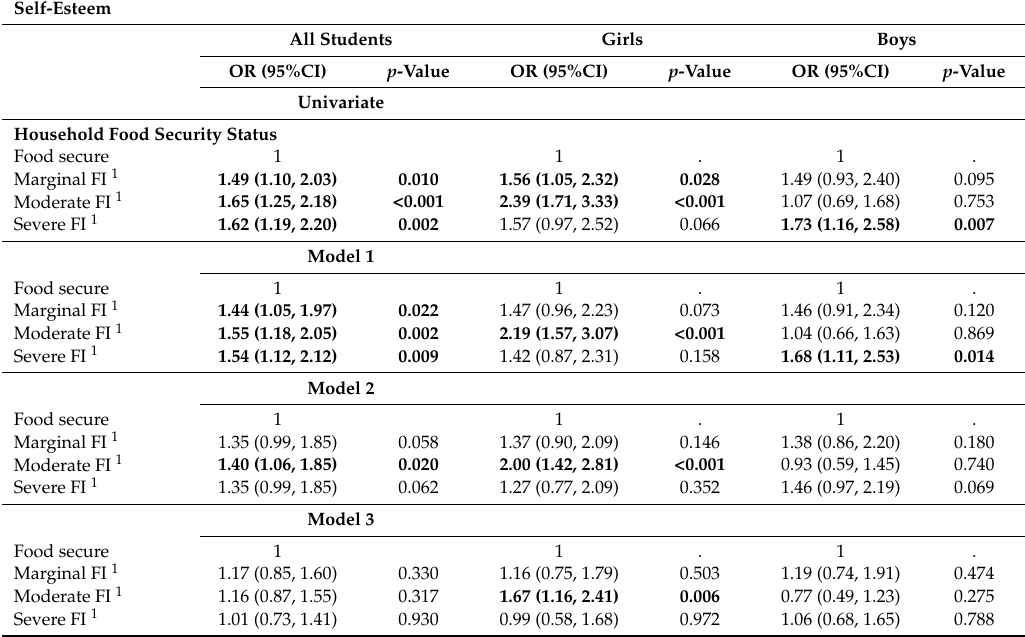
Table 2. Relationship between food security and low self-esteem among grade 5 students (aged 10–11 years) in Nova Scotia,